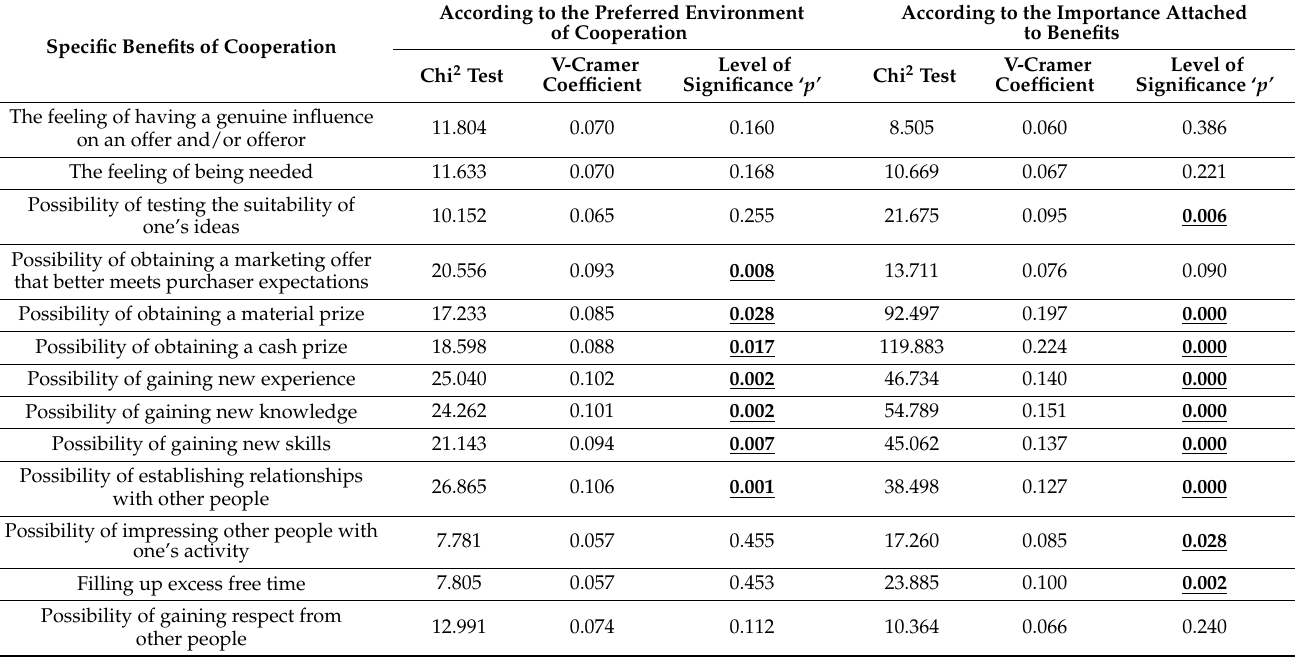
Table 5. Specific benefits chosen by the respondents which a final purchaser achieves thanks to cooperation with offerors compared with the preferred environment of cooperation and the importance attached to the benefits achieved according to their general